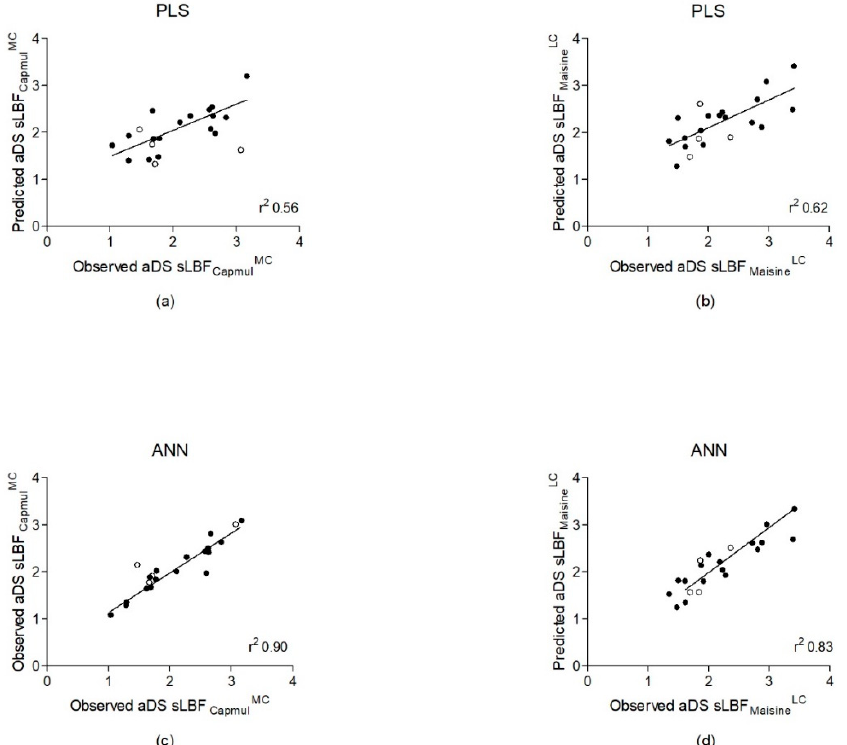
Figure 3. Scatter plots illustrating the predicted versus observed aDS values obtained for aDS sLBF CapmulMC using PLS ( r 2 = 0.56) and ANNs ( r 2 = 0.90) ( a , c ). Scatter plots illustrating the predicted versus observed aDS values obtained for aDS sLBF MaisineLC using PLS ( r 2 = 0.62) and ANNs ( r 2 = 0.83) ( b , d ).